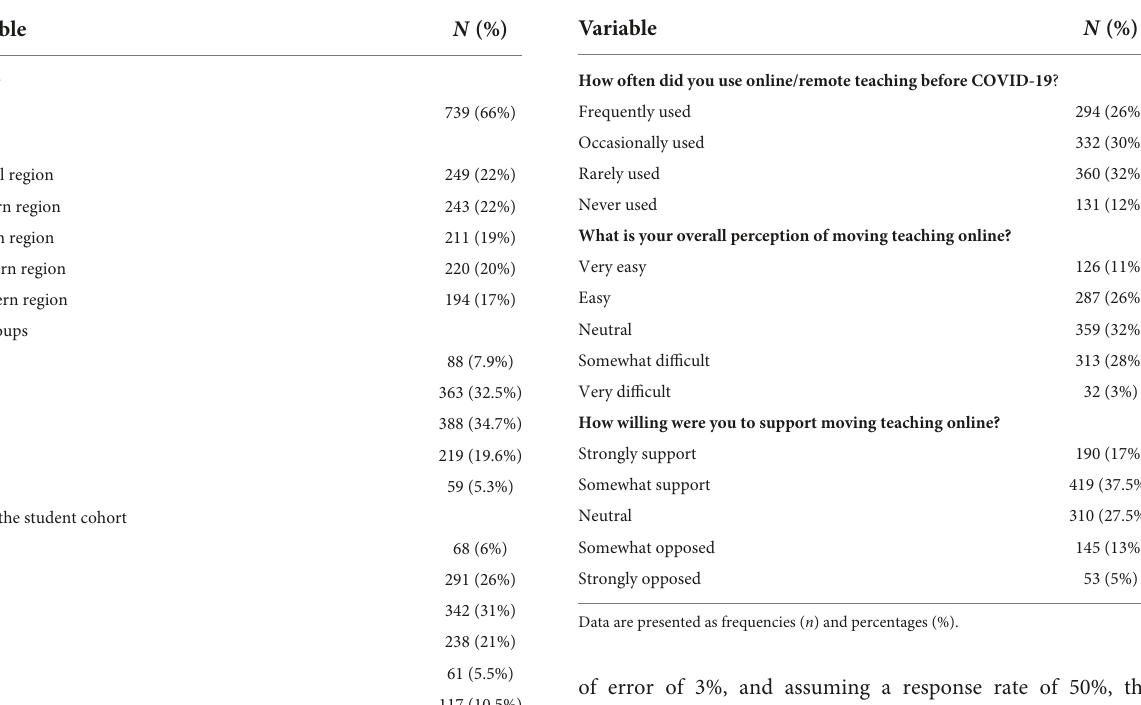
TABLE 1 Demographic data and characteristics of the respondents ( n =